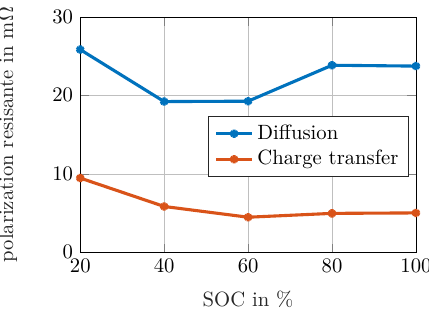
Figure 9. Polarization resistance of (presumably anodic) charge transfer (peak 4) reaction and the value obtained by the DRT for the diffusion of both electrodes (which must not be interpreted as an absolute resistance